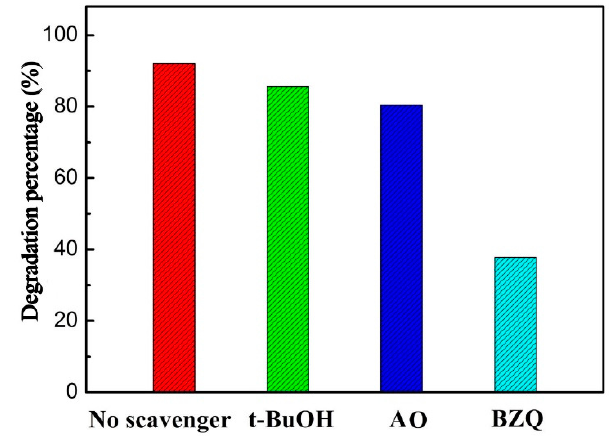
Figure 10. Effect of various scavengers on the visible light photocatalytic performance of 1.5L-ZIS sample toward the photodegradation of TCH.